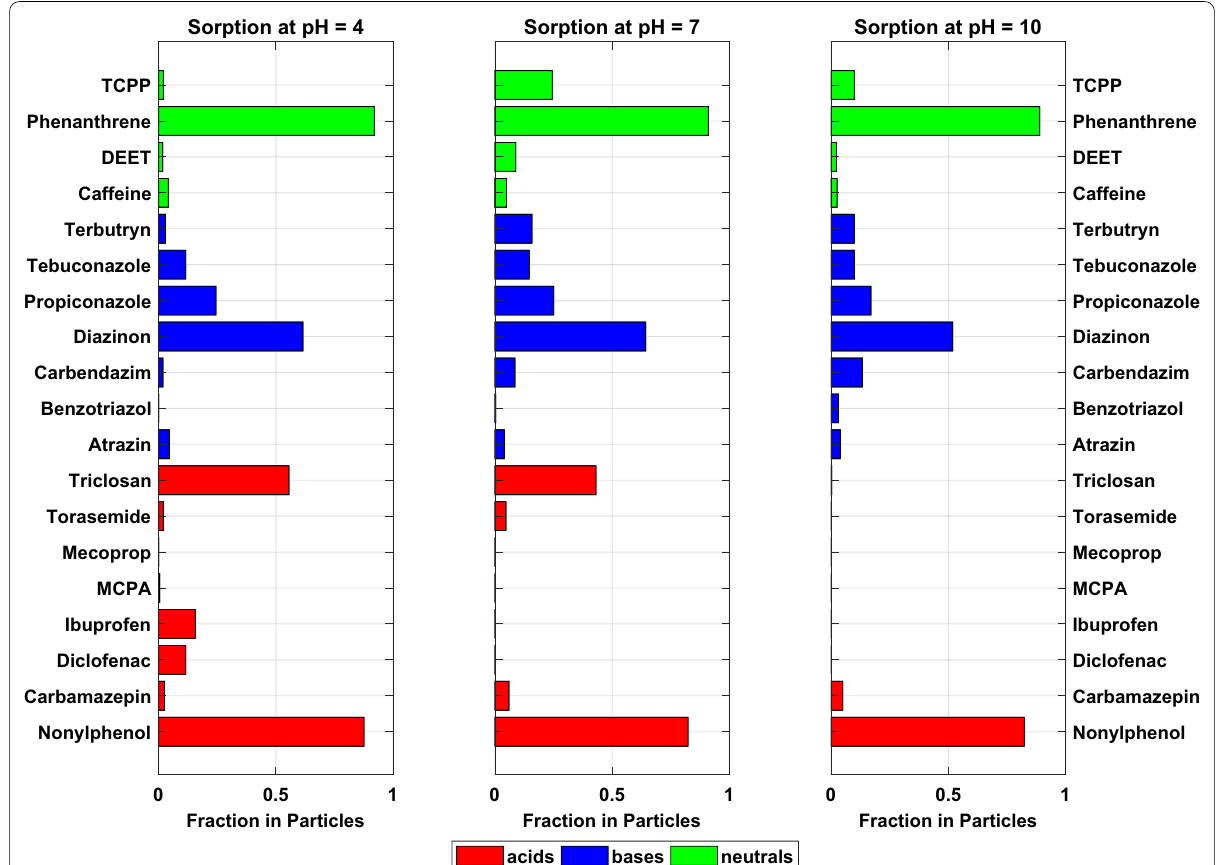
Fig. 1 Sorbed fractions of the investigated contaminants to polyethylene at different pH levels. The bars are colored according to the acid/base properties of the substances as indicated in the legend. For substances for which a negative D P has been determined, the sorbed percentage was set to